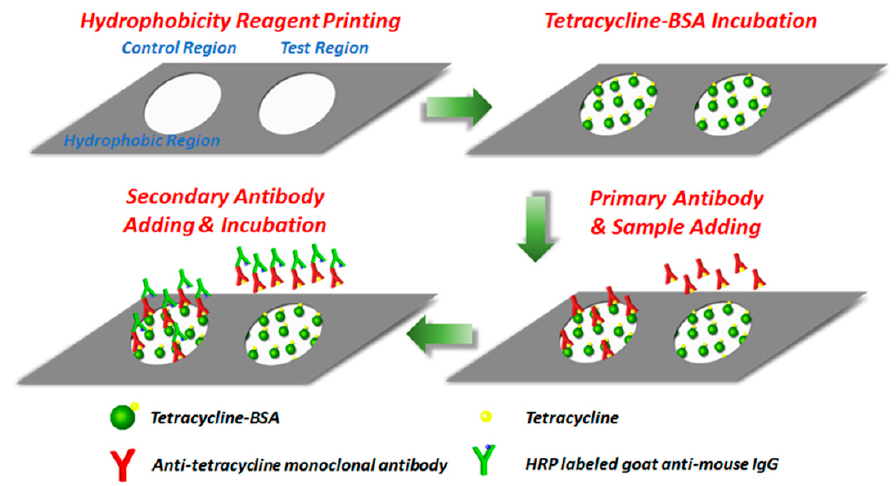
Figure 1. The inkjet printing paper chip based ELISA testing process.